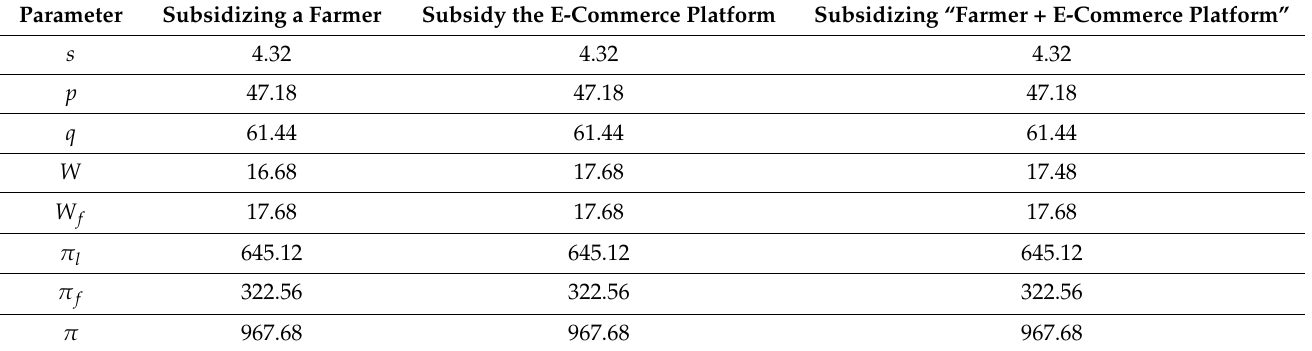
Table 6. Comparison of optimal decision and profit level under government subsidy supply